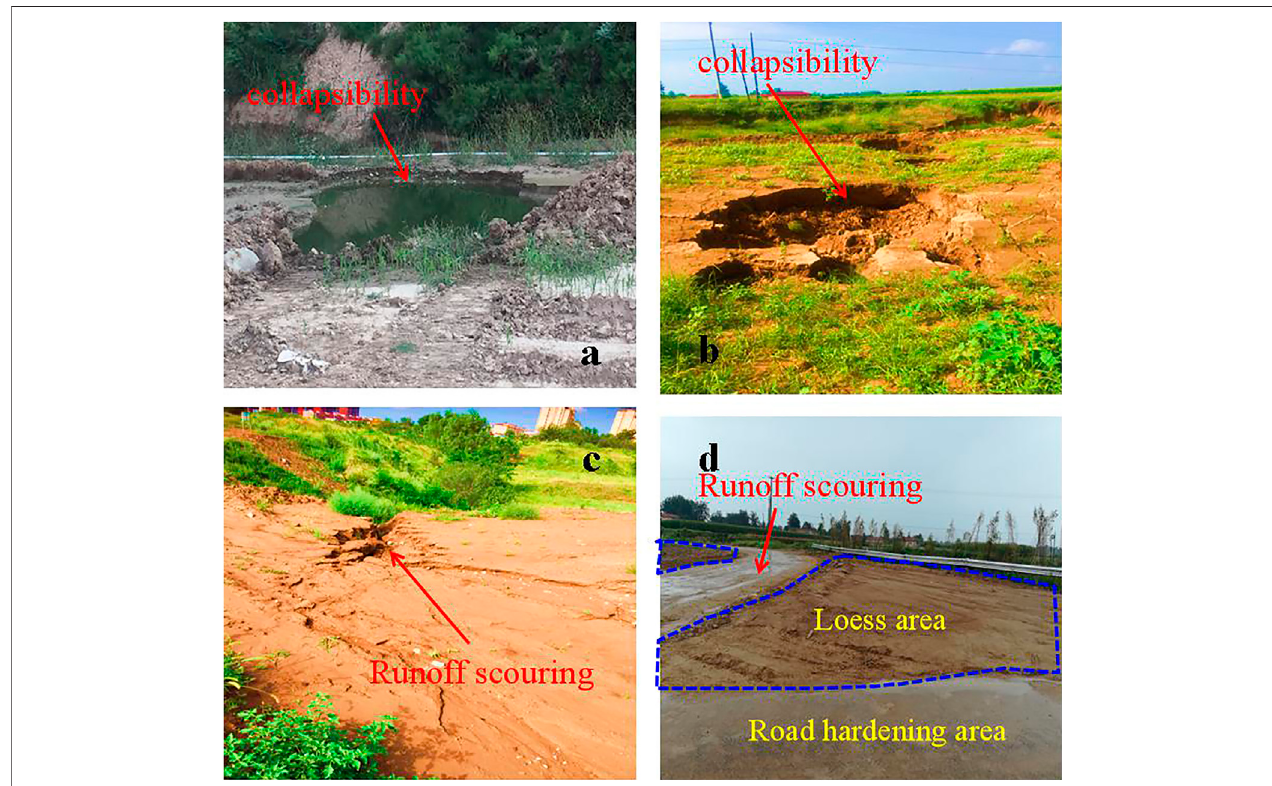
FIGURE 5 | Status of protection of gully land fi ll without regional drainage measures.